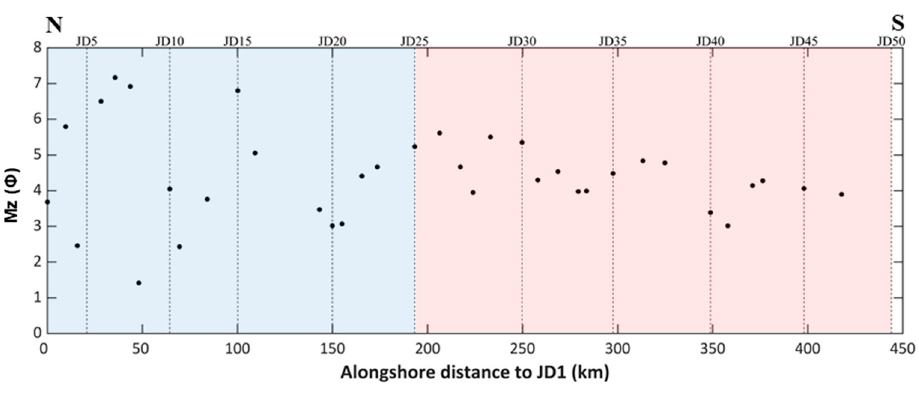
Figure 8. Averaged (through profile) bed surface mean sediment grain size of each